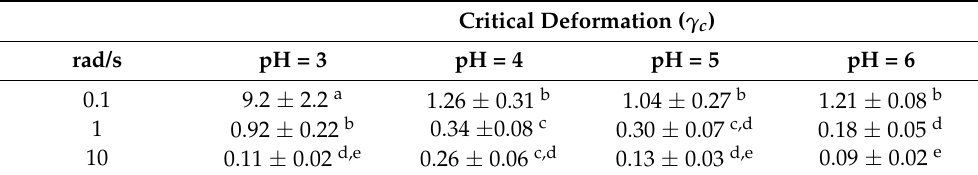
Table 1. Values of critical deformation ( γ c ) within the linear viscoelastic range for egg yolk acidified with citric acid at different pH and frequency values. Different letters indicate significant differences ( p <